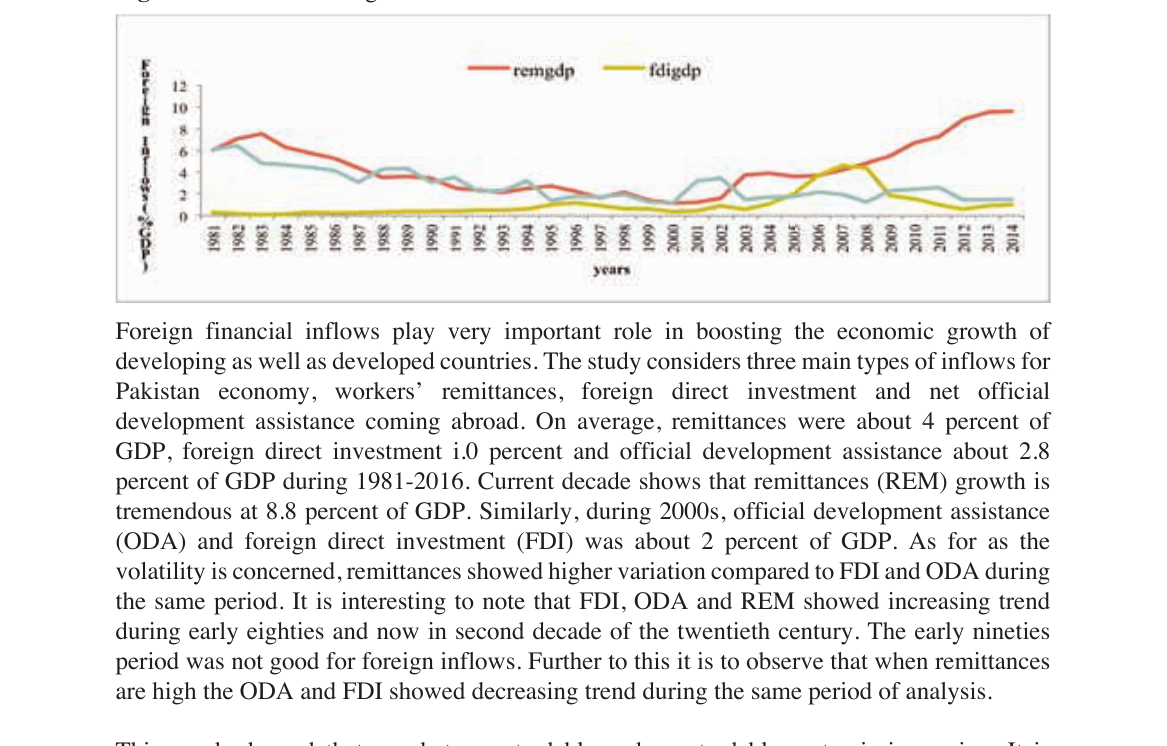
Figure 2: Trend of Foreign Financial Inflows